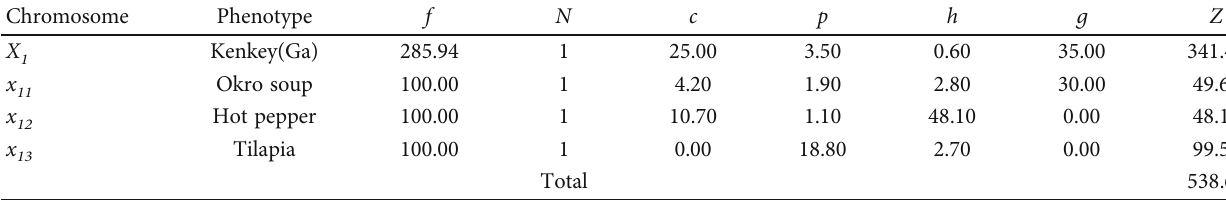
Table 3: Sample chromosome representation of parent meal X